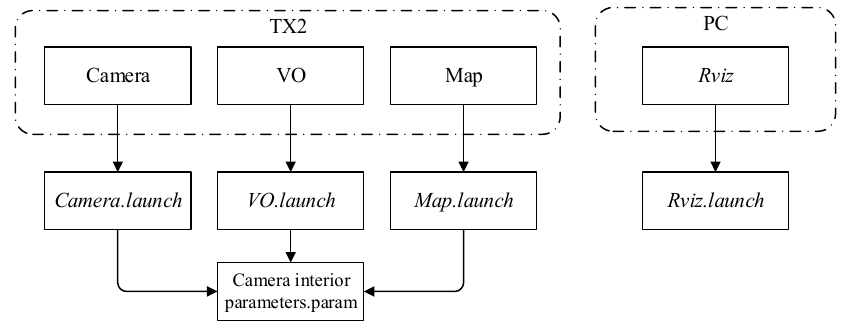
Figure 20. Schematic diagram of running nodes through the launch file.